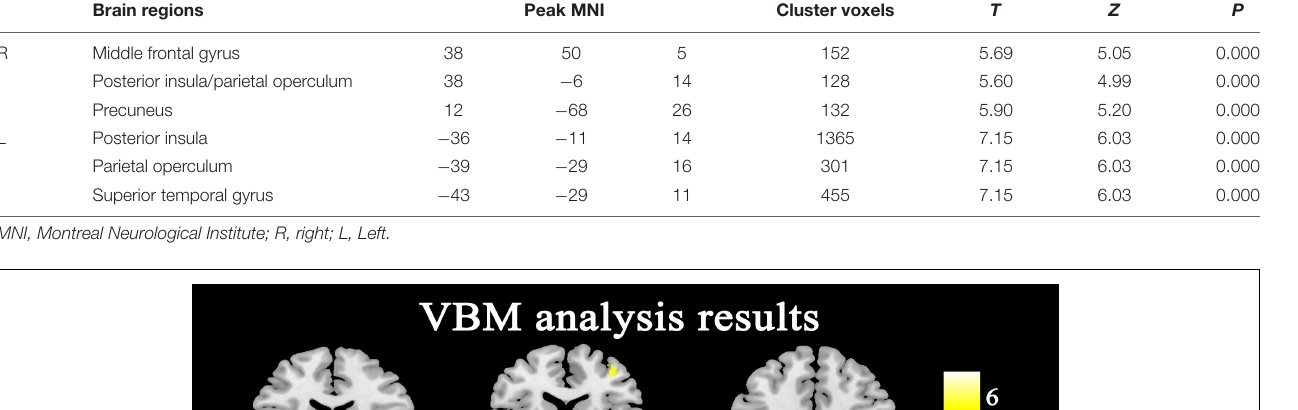
TABLE 2 | Decreased gray matter volume in various brain regions in patients with vestibular migraine. Brain regions Peak MNI